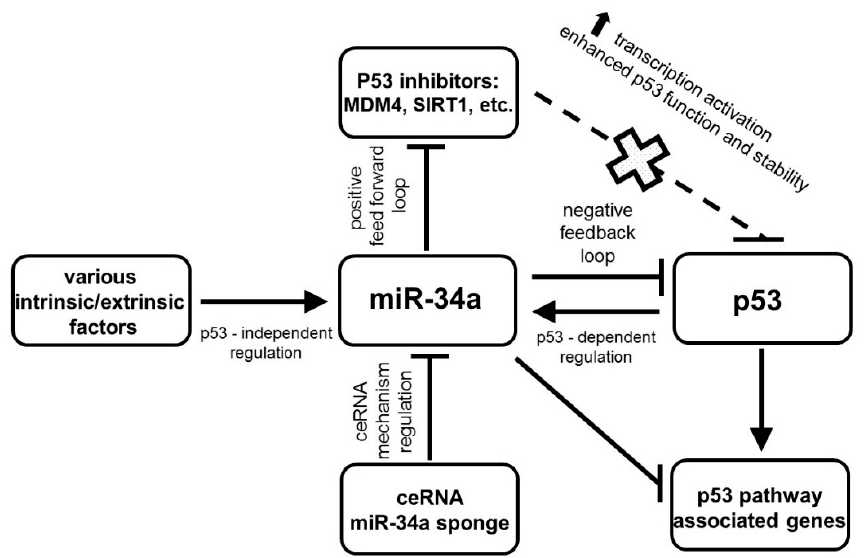
Figure 2. Regulatory mechanisms of miR-34a expression.